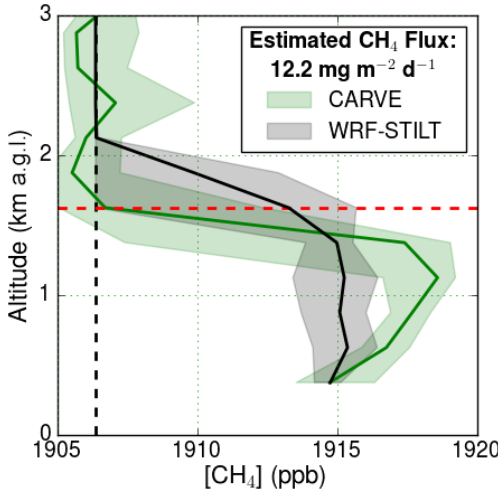
Figure 3. A sample profile from 3 September 2014 at 65 ◦ N, 148.6 ◦ W. Shaded regions denote the minimum and maximum of the ranges and the solid line is the median. The dashed red line rep- resents h , and the dashed black line is [CH 4 ] 0